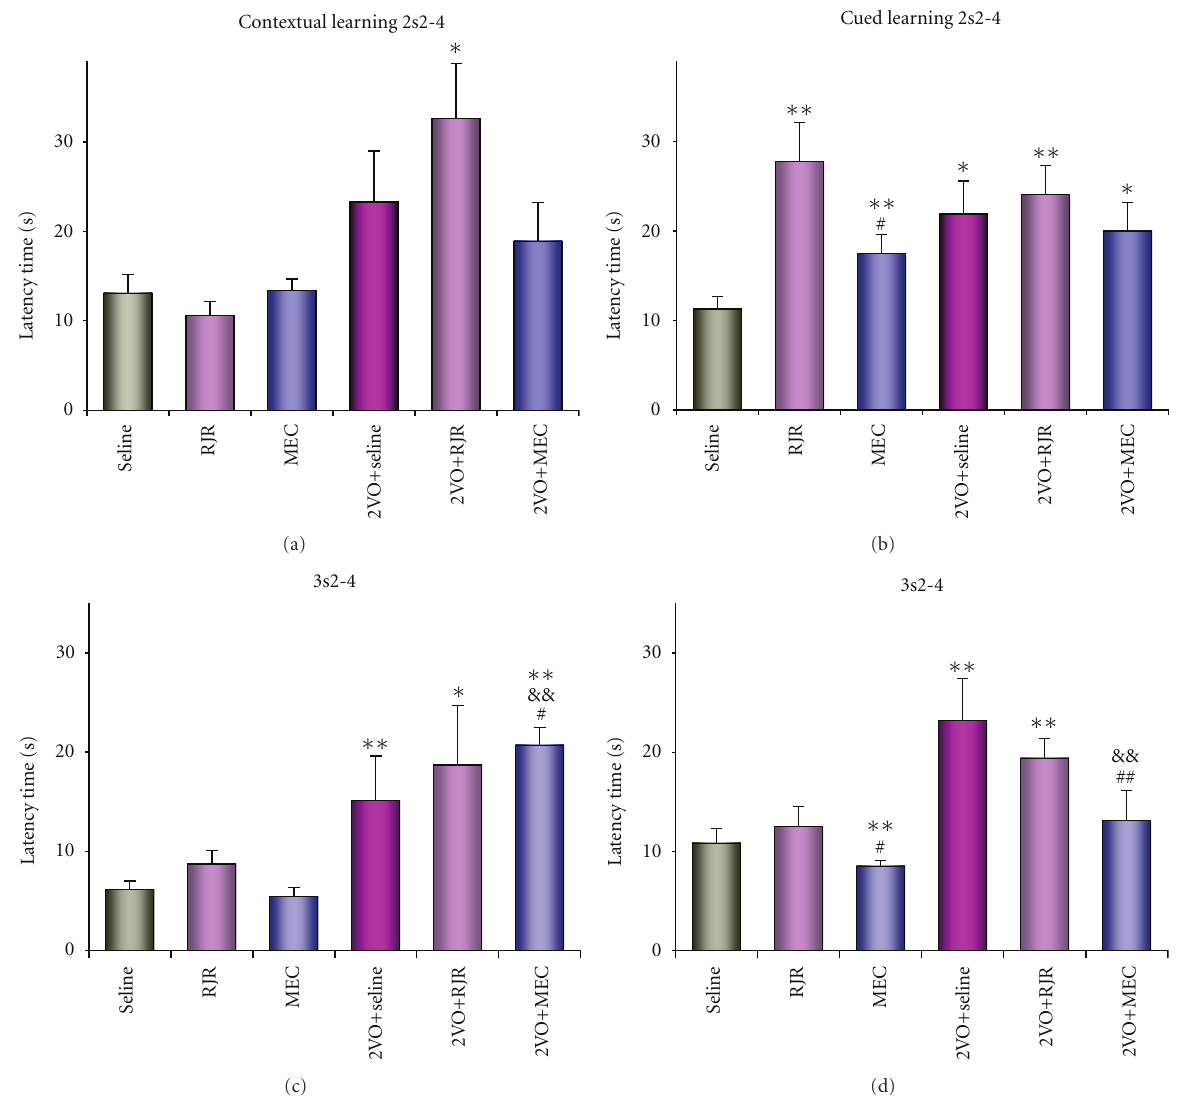
Figure 6: Influence of the agonist of α 4 β 2 subtype of nAChR RJR and the antagonist of non- α 7 subtype of nAChR mecamilamine (MEC) on learning 2s2–4 (top row of figures) and 3s2–4 (bottom row of figures) in rats in the Morris water maze in the spatial contextual and the spatial cued models under control and 2VO conditions. The learning performance is presented as latency time (sec). Seline, control rat’s groups ( n = 12 for learning as 2s2–4 and 3s2–4 in the contextual model; n = 13 for the ones in the cued model); RJR, MEC, groups of rats with RJR or MEC administered under the normal conditions ( n = 6 for both groups for learning as 2s2–4 and 3s2–4 in the contextual model; n = 7, 11 for learning 2s2–4 in RJR, MEC groups, respectively, and n = 10, 11 for learning 3s2–4 in ones in the cued model); 2VO + seline, the 2VO rat’s group ( n = 9 for learning as 2s2–4 and 3s2–4 in the contextual model; n = 7 for the ones in the cued model); 2VO + RJR, 2VO + MEC, groups of rats with RJR or MEC administered under the 2VO conditions (resp., n = 9, 10 for learning as 2s2–4 and 3s2–4 in the contextual model; n = 8, 9 for the ones in the cued model). ∗ , ∗∗ , significant di ff erences from control rat’s group ( P < . 05 and P < . 025, resp.); # , ## , significant di ff erences between RJR and MEC or 2VO + RJR and 2VO + MEC rat’s groups ( P < . 05 and P < . 025,